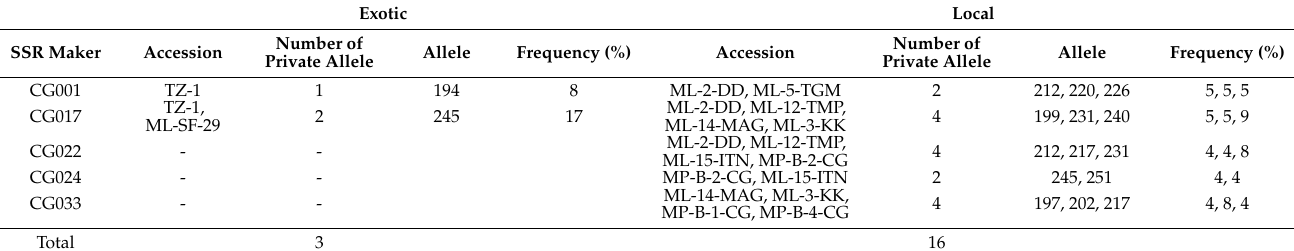
Table 9. List of accessions with one or more private alleles. Exotic Local